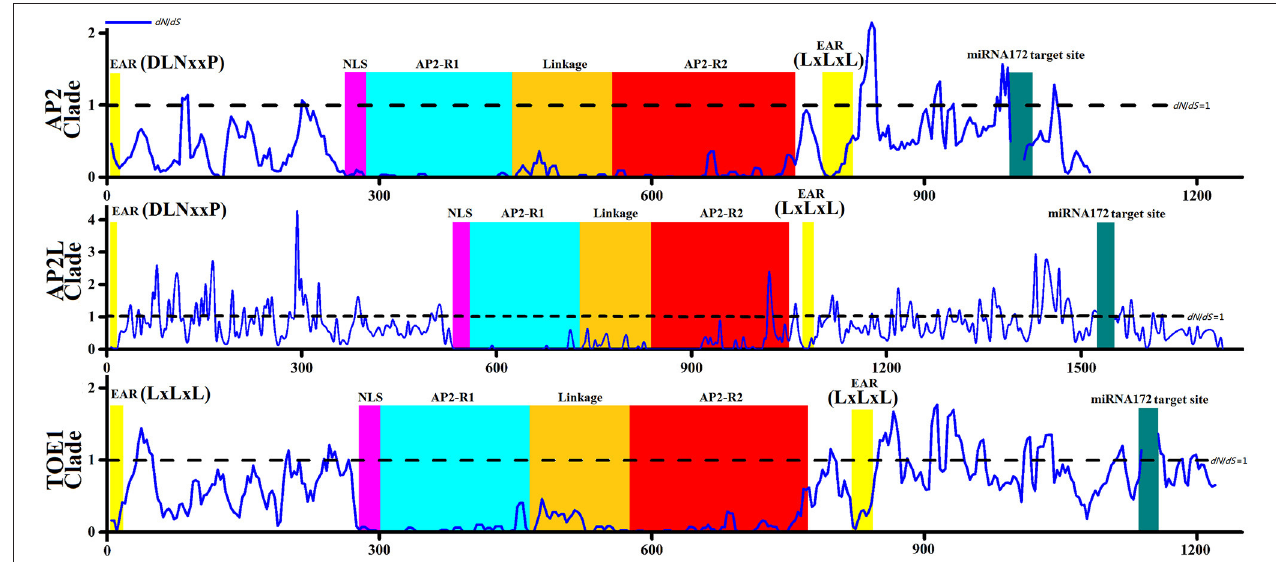
FIGURE 4 | Sliding-window Analyses of dN / dS among Three Clades Genes (AP2 clade,AP2L clade, and TOE1 clade). The sliding-window analyses were performed using a 30-bp sliding window moving in steps of 3-bp. Numbers on the x-axis represent the sequence positions followed below by the domain map of genes. The homeodomains (EAR domain, NLS domain, AP2-R1 domain, linkage domain; AP2-R2 domain, miRNA172 target site) were showed by the same colors with Image 1 . The straight lines shown in the figure represent dN = dS